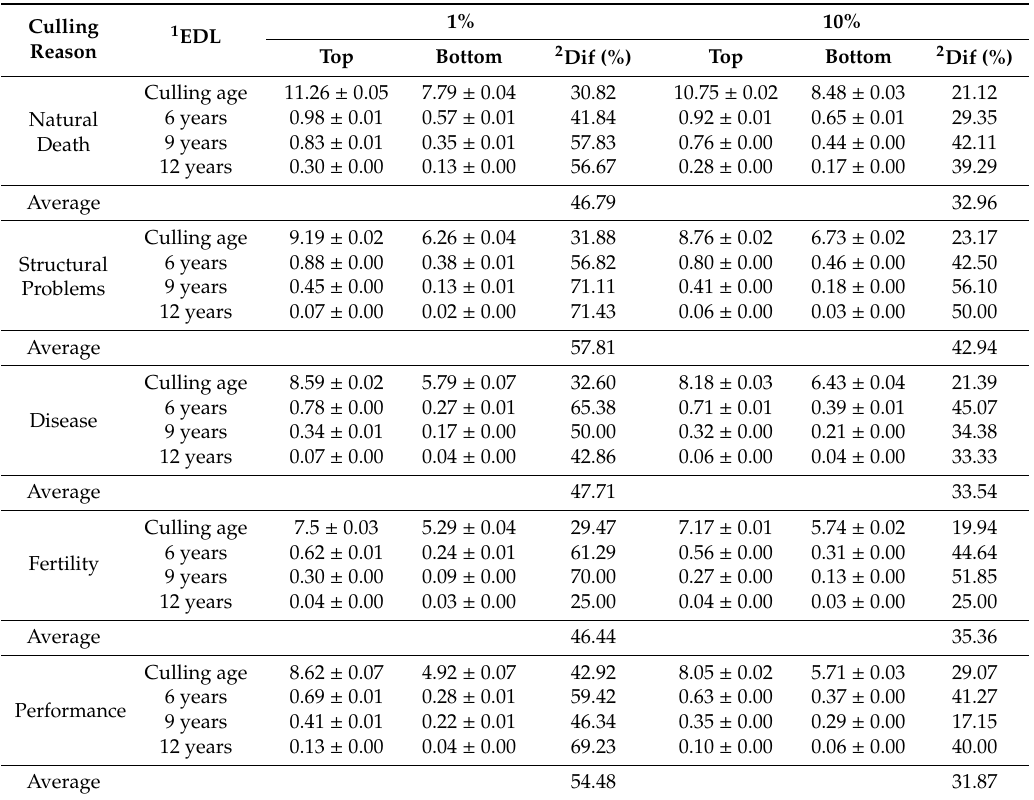
Table 10. Average ( ± SE) expected daughter longevity (EDL) predicted for the top and bottom 1% and 10% sires, considering di ff erent groups of known culling reasons and selection at 4 years-old for functional longevity assuming 0 after the cow was culled or if the cow did not record a calf at the specified